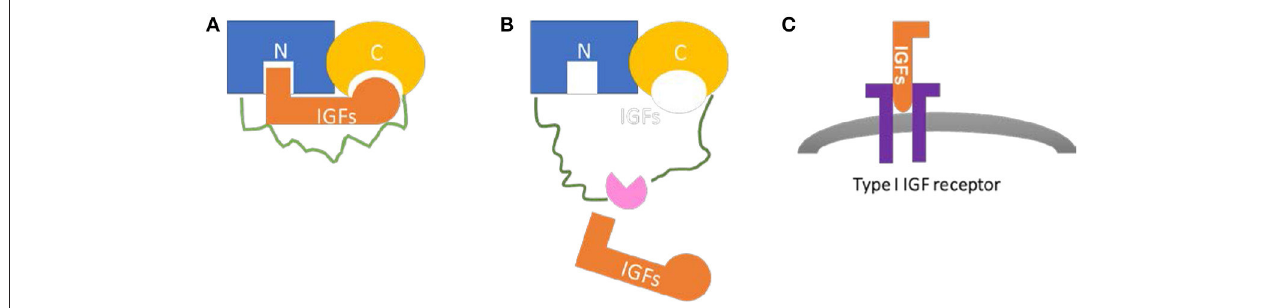
FIGURE 1 | Common structure and biological function of IGFBPs. (A) The N-terminal region (blue) and the C-terminal region (yellow) are connected by a linker region (green). Both N-domain and C-domain contains a binding site for IGFs (orange). (B) The proteolysis of IGFBPs by various proteases (pink) occurs in the linker region or other post-translational modifications, may result in IGFs release. (C) Once released from IGFBPs, IGFs bind to IGF receptors (purple) to exert their physiological effects.